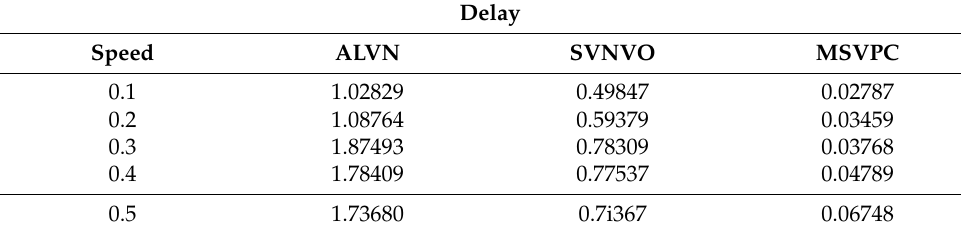
Table 3. Node vs. delay.